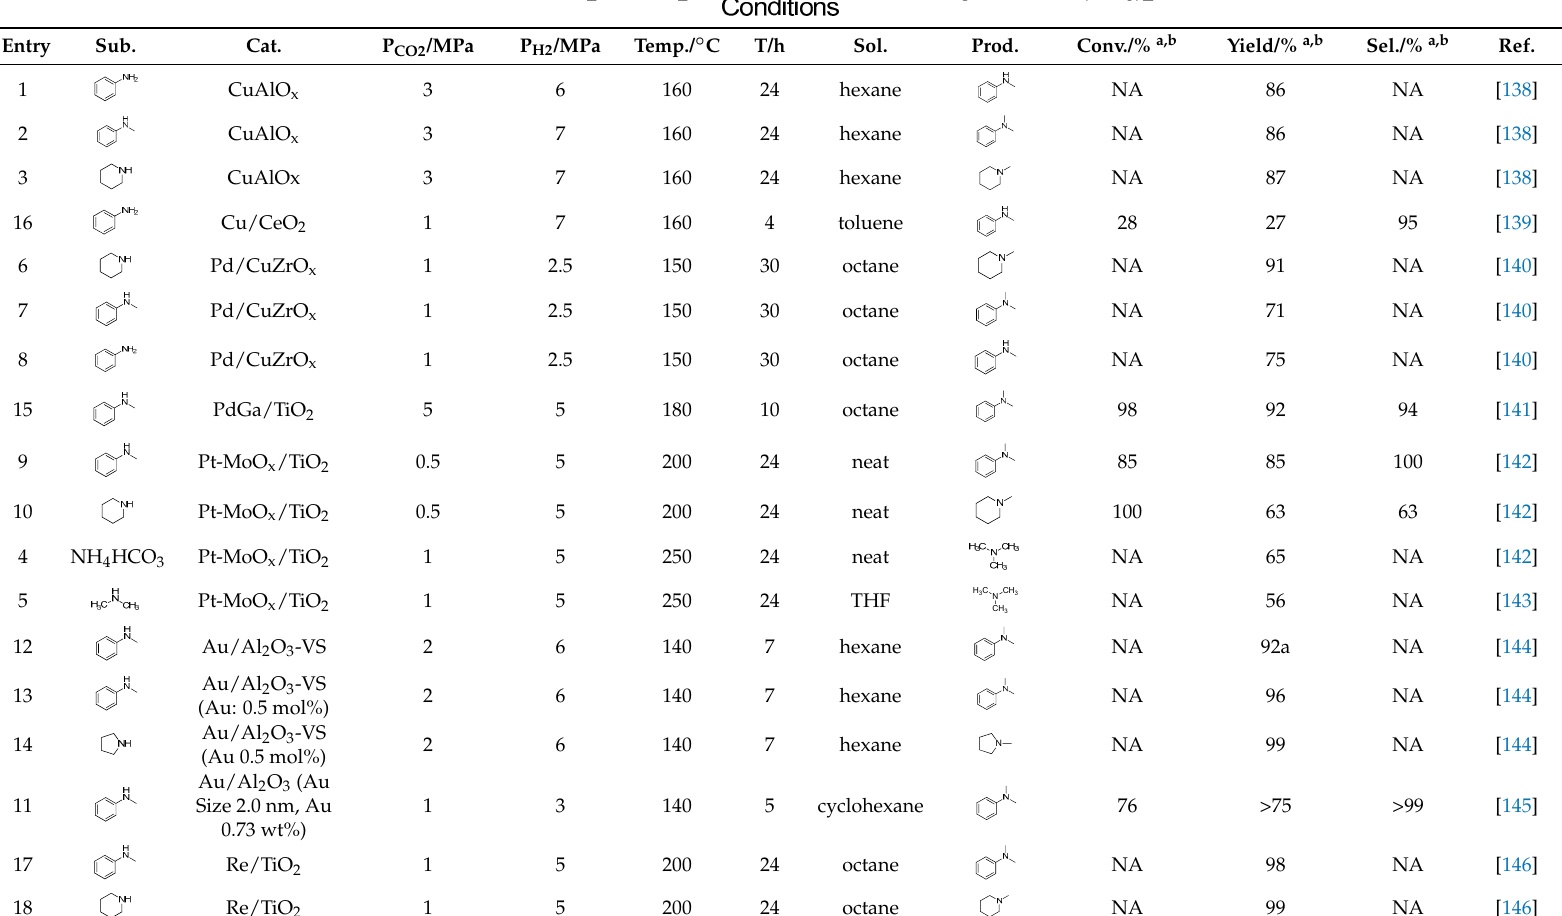
Table 4. Methylation of selective amines with CO 2 and H 2.